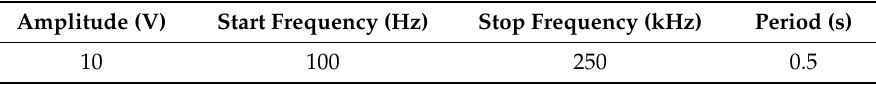
Figure 5 . Low-velocity impact test setup ( a ) test setup; ( b ) data acquisition system. Table 4. Parameters of the excited swept sine wave signal.